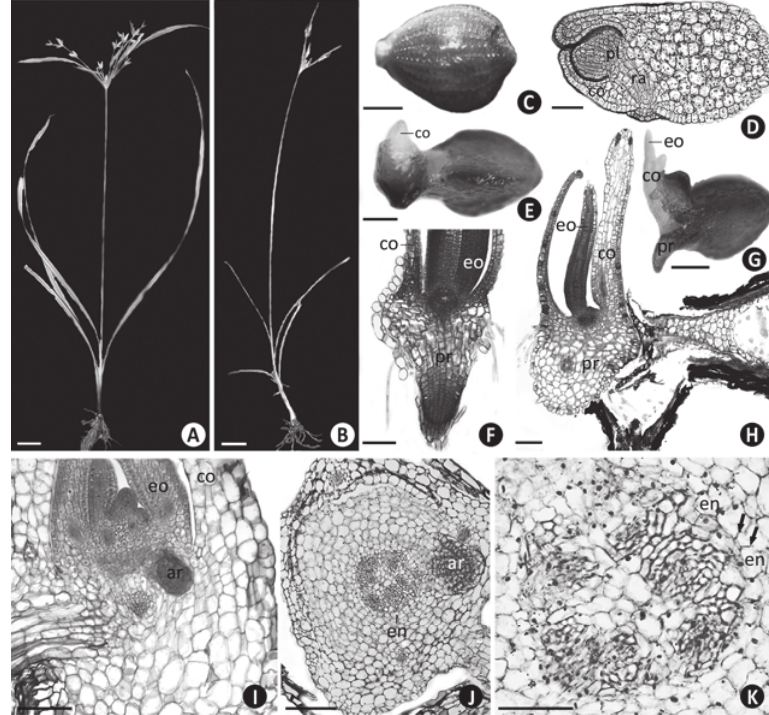
Fig. 1 - Morphological and anatomical aspects of Cyperaceae species: Cyperus laxus L. and Fimbristylis dichotoma Vahl. Fimbristylis dichotoma Vahl. Fimbristylis dichotoma A. Cyperus laxus , habit; B-C. Fimbristylis dichotoma ; B. Habit; C. Achene; D. Cyperus laxus , general view of the embryo in paradermic section; E-H. Morphology and anatomy of the post-seminal stages of development in Cyperus laxus ( E, G, H ) and Fimbristylis dichotoma ( F ); I-K. Cyperus laxus ; I. General view of the mesocotyl; J. General view of young rhizome showing the radial cells originating from the precursor cells of the endodermis; K. Detail of the young rhizome showing Casparian strips in the endodermal cells (arrows). ar = adventitious root; co = coleptile; en = endodermis; eo = eophyll; pr = primary root; ra = radicle. Bars = 2 cm ( A, B ); 1 cm ( C, E, G ); 100 µm ( F, H, I, J ); 50 µm ( D, K